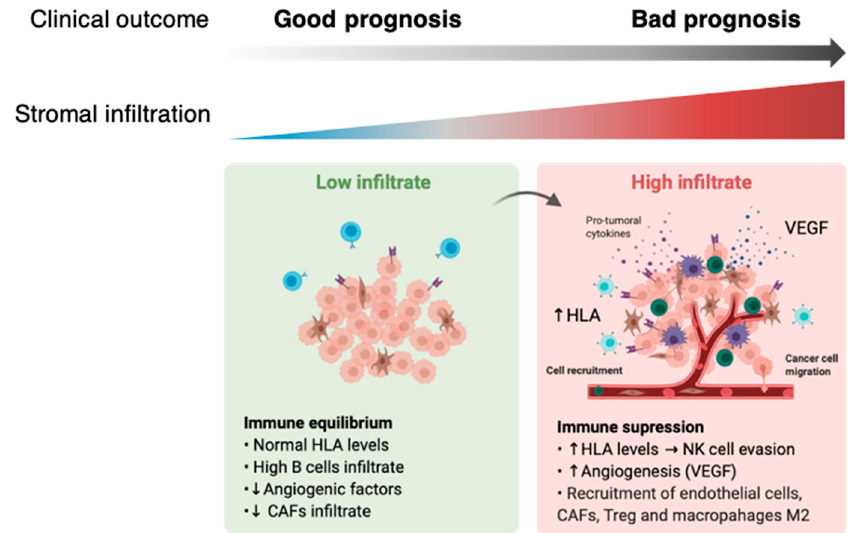
Figure 6. Hypothesis. Our results suggest a combinatory function of angiogenesis and inflammation in UM tumors. Infiltration of macrophages, fibroblasts and natural killer (NK) cells is associated with poor prognosis, whereas infiltration of B cells is associated with good prognosis. HLA over-expression could trigger a mechanism to evade the NK-cells mediated attack. This immunosuppressive environment, together with the high levels of stromal activity and checkpoints blockade, allows UM cells to disseminate and metastasize. New therapeutic strategies such as, combining immune checkpoint inhibitors (anti-programmed death ligand 1 (PDL1) or anti-cytotoxic T-lymphocyte antigen-4 (CTLA4)) with anti-angiogenic targeted therapy (anti-vascular endothelial growth factor (VEGF)) could improve patients’ response. Figure created with BioRender.com.